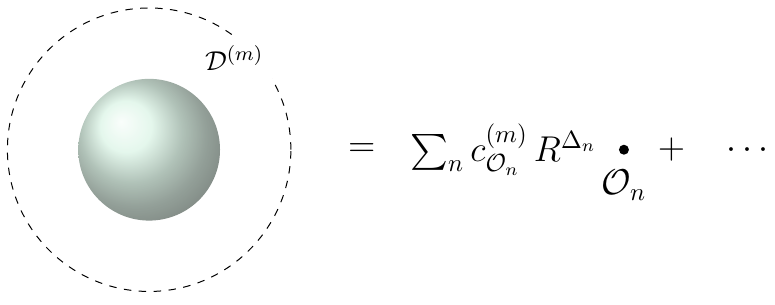
Figure 4 . A schematic picture of the OPE for conformal